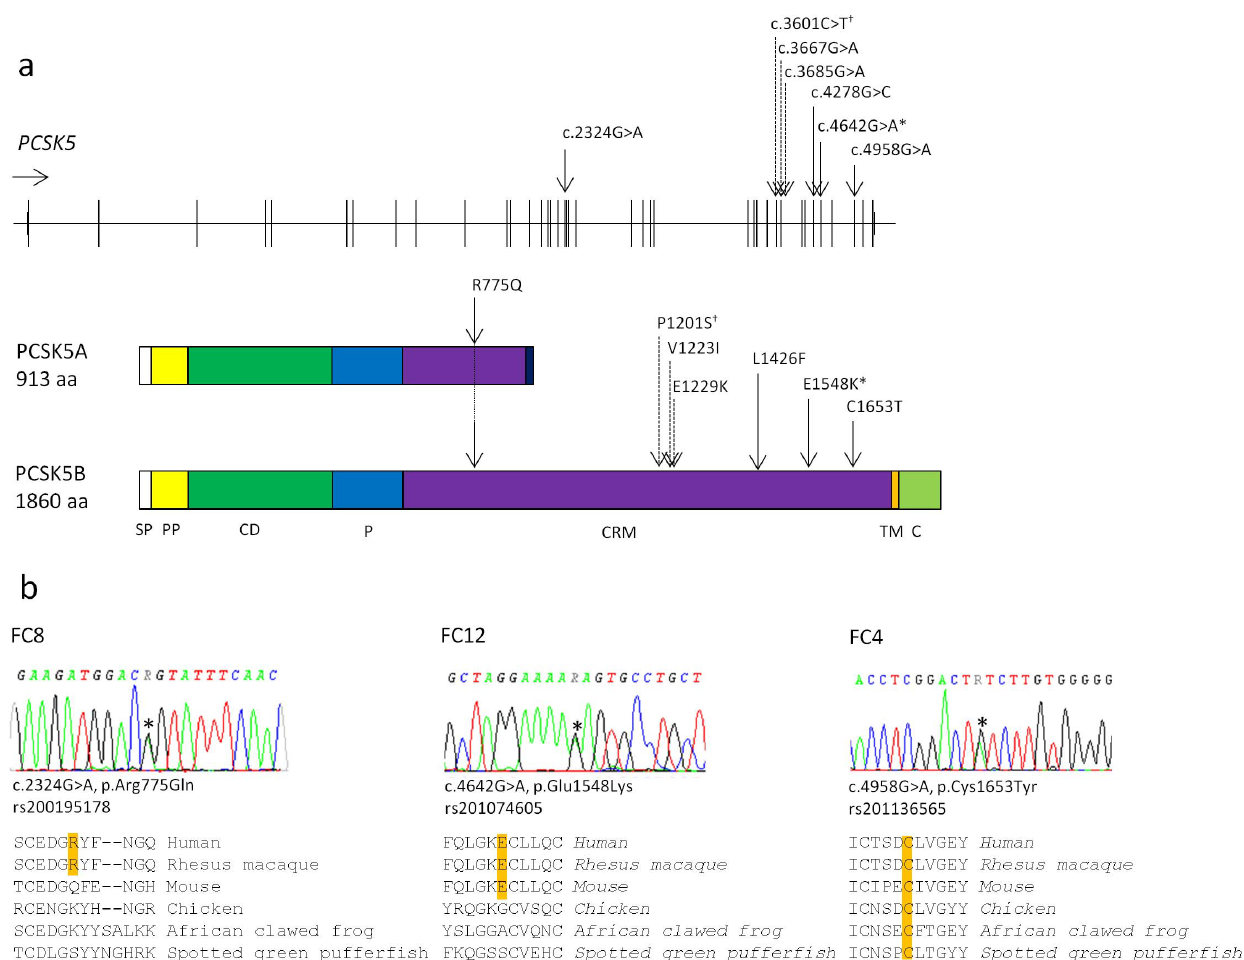
Figure 3. Results from DNA sequencing of the PCSK5 gene and protein sequence alignment. a. Upper part showing exons of the PCSK5 gene (ENSG00000099139) with location of detected sequence variants indicated by black arrows (our study) and crosshatched arrows (Szumska et al.)[18]. Star indicates variant detected in one fetal case in our study and in two patients by Szumska et al. (c.4642G . A, p.Glu1548Lys). Lower part of figure showing the two isoforms of PCSK5 with protein domains, based on image from Seidah et al. [35]. Prolonged arrow indicating the amino acid change p.Arg775Gln in both PCSK5 protein isoforms. Dagger indicates variant that was reported by Szumska et al. and was later reported as a non- synonymous coding SNP (rs114508164, P1201S). SP signal peptide, PP propeptide, CD catalytic domain, P P-domain, CRM cysteine-rich motif, TM transmembrane domain, C cytosolic tail. b. Results from PCSK5 DNA sequencing show heterozygous missense variants (*) in fetal cases FC8, FC12 and FC4. For each detected variant, the corresponding protein sequence alignment of 6 vertebrate PCSK5B sequences is shown beneath, revealing conservation of Cys-1653 in all 6 species (mammals, birds, amphibians and fish), Glu-1548 in mammals and Arg-775 only in primates.